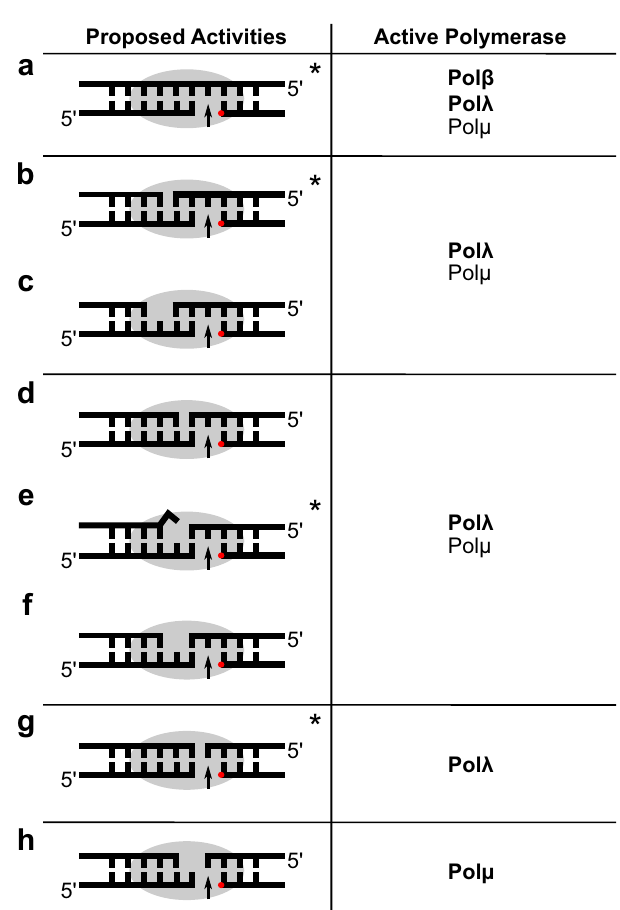
Fig. 1 Schematic diagram of DNA substrates utilized by Family X polymerases. Single- and double-strand break DNA substrates are shown in stick on the left, with the rough footprint of the bound polymerase indicated by a gray oval. Locations of the 5 ʹ -phosphate (if present) and the incoming nucleotide to fi ll the gap are given by a red dot and an upward black arrow, respectively. Polymerases that have been found to utilize each type of substate are listed on the right, with the identities of the polymerase shown to predominantly repair this con fi guration shown in bold. Types of substrates include single-strand breaks ( a ) and double-strand breaks with 2nt ( b , c ) or 1nt ( d – f ) complementarity, blunt-ended breaks ( g ), or noncomplementary breaks ( h ). Crystal structures of substrates with asterisks will be presented in this